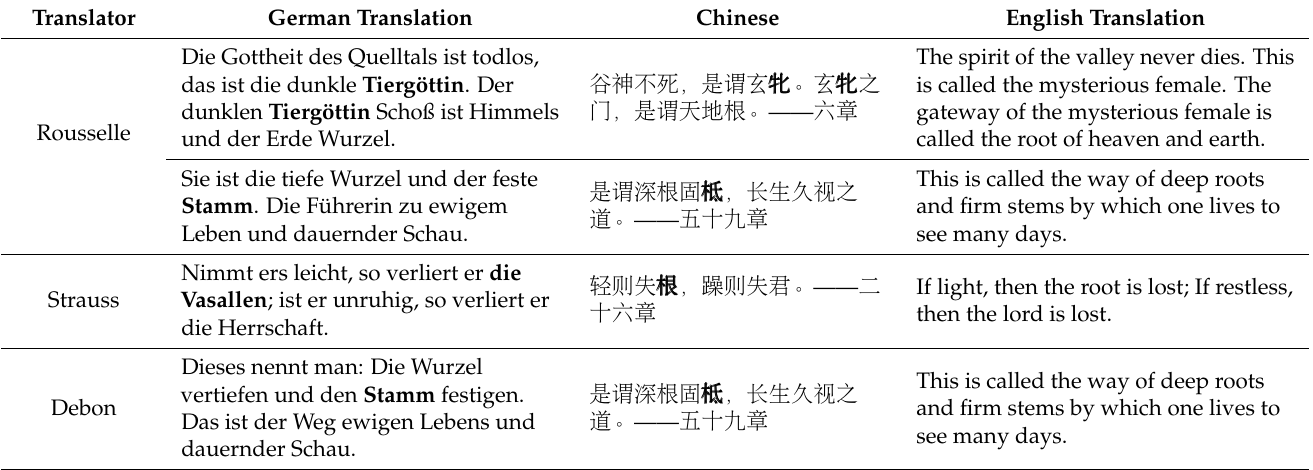
Table 5. The Conversion of Xi à ng in German